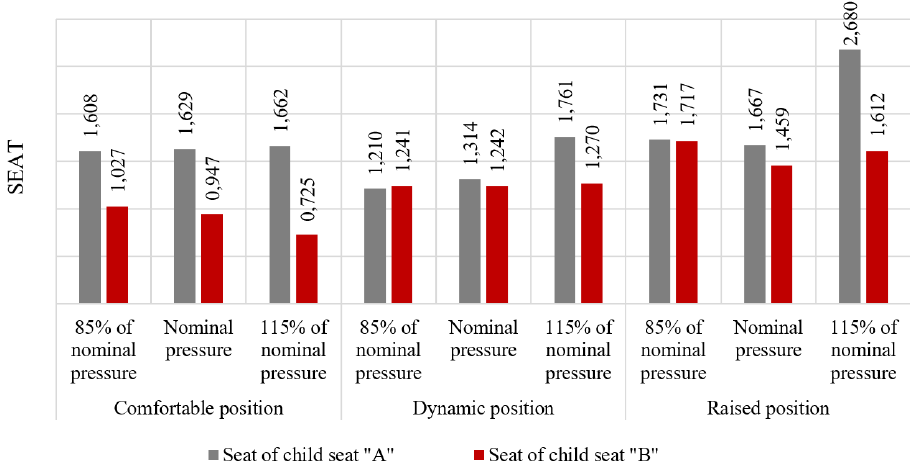
Figure 17: SEAT indicator on the seat of the tested child seats with a load of 7.5 kg